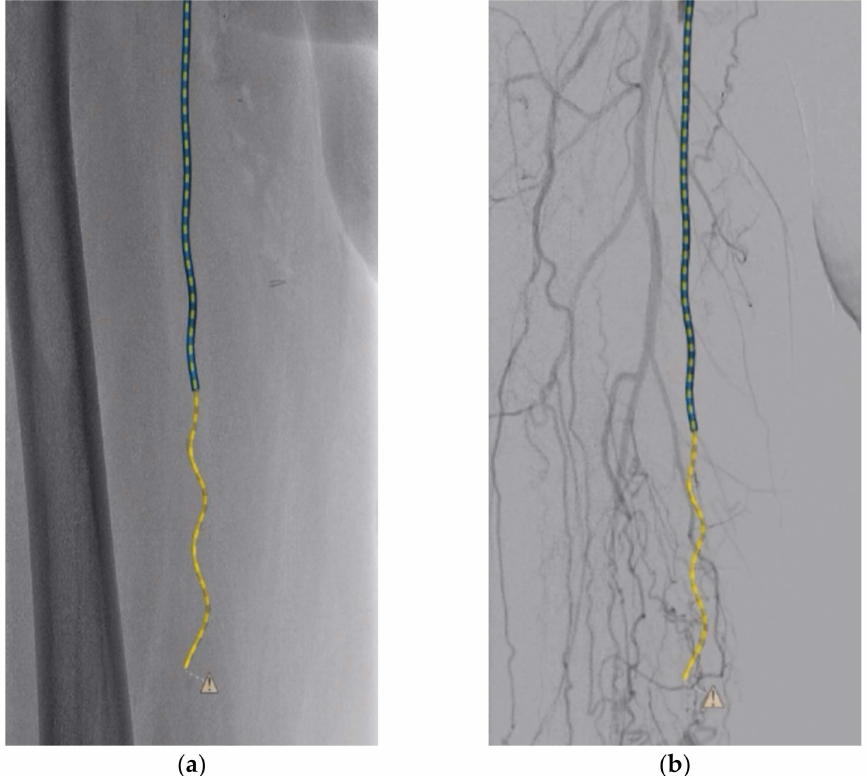
Figure 4. Example of FORS guidewire visualization with dashed line during recanalization of the occluded SFA with fluoroscopic ( a ) and DSA ( b ) background. The FORS technology visualizes devices with a dashed line during a period when excessive force on the guidewire impairs the optical signal, exceeding the boundary conditions for guidewire shape